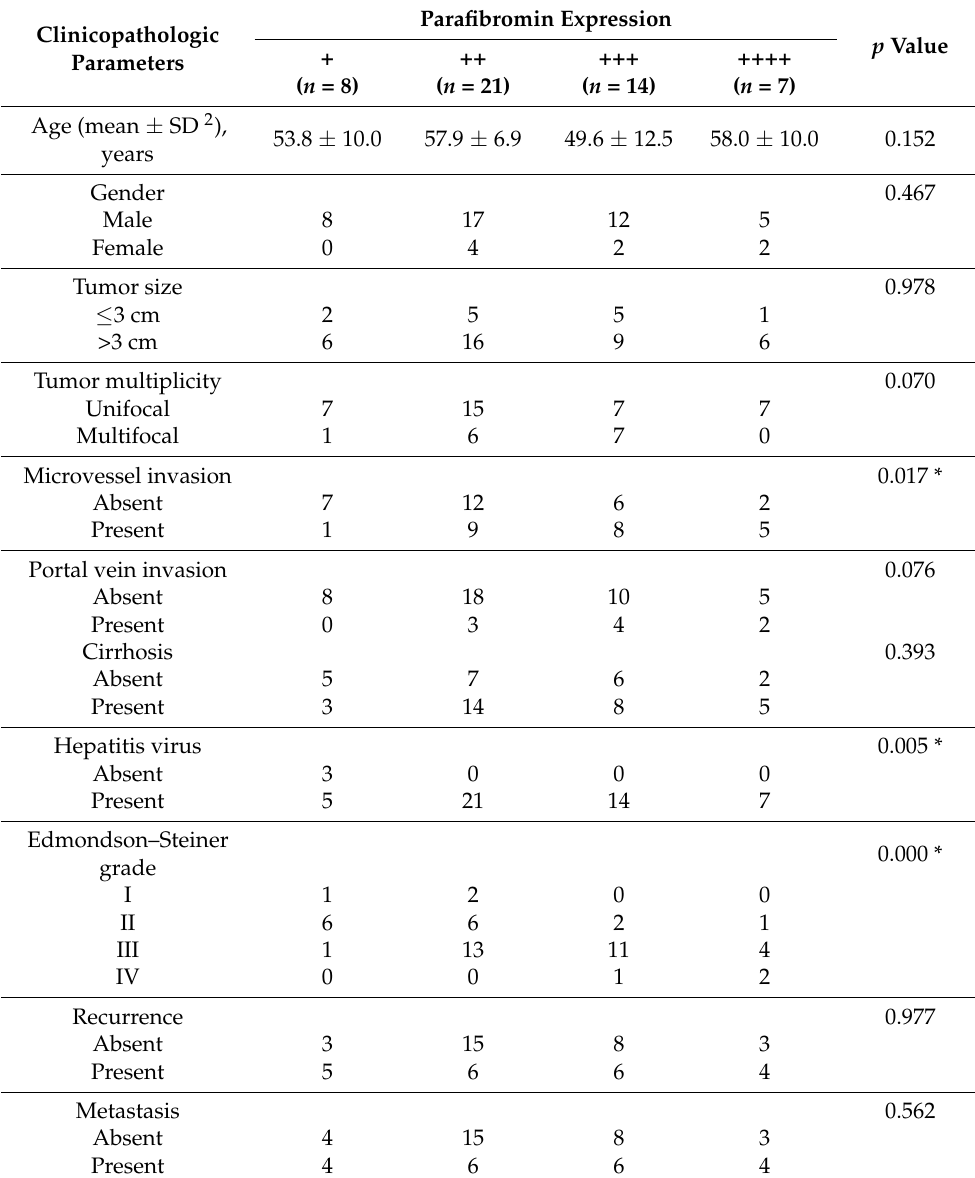
Table 1. Associations between parafibromin expression and clinicopathologic parameters in patients with HCC 1